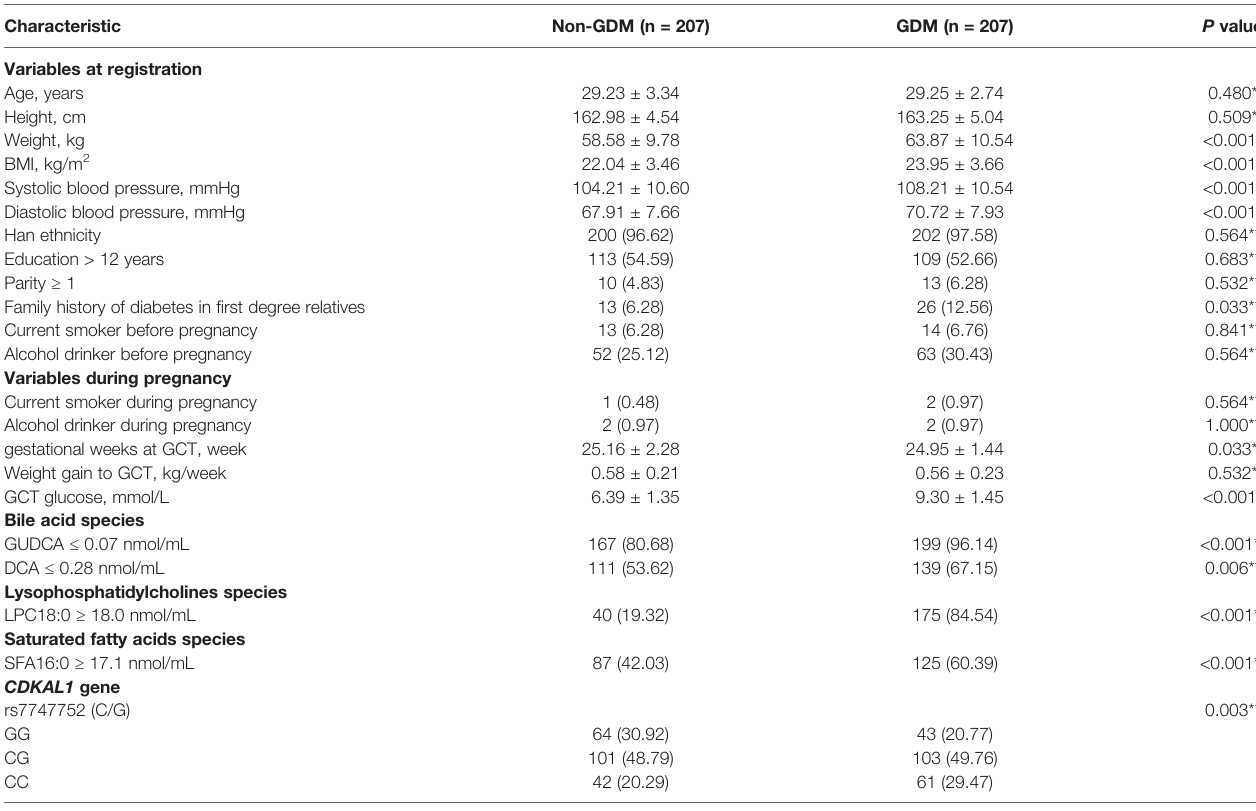
TABLE 1 | Clinical and biochemical characteristics of GDM and non-GDM women.